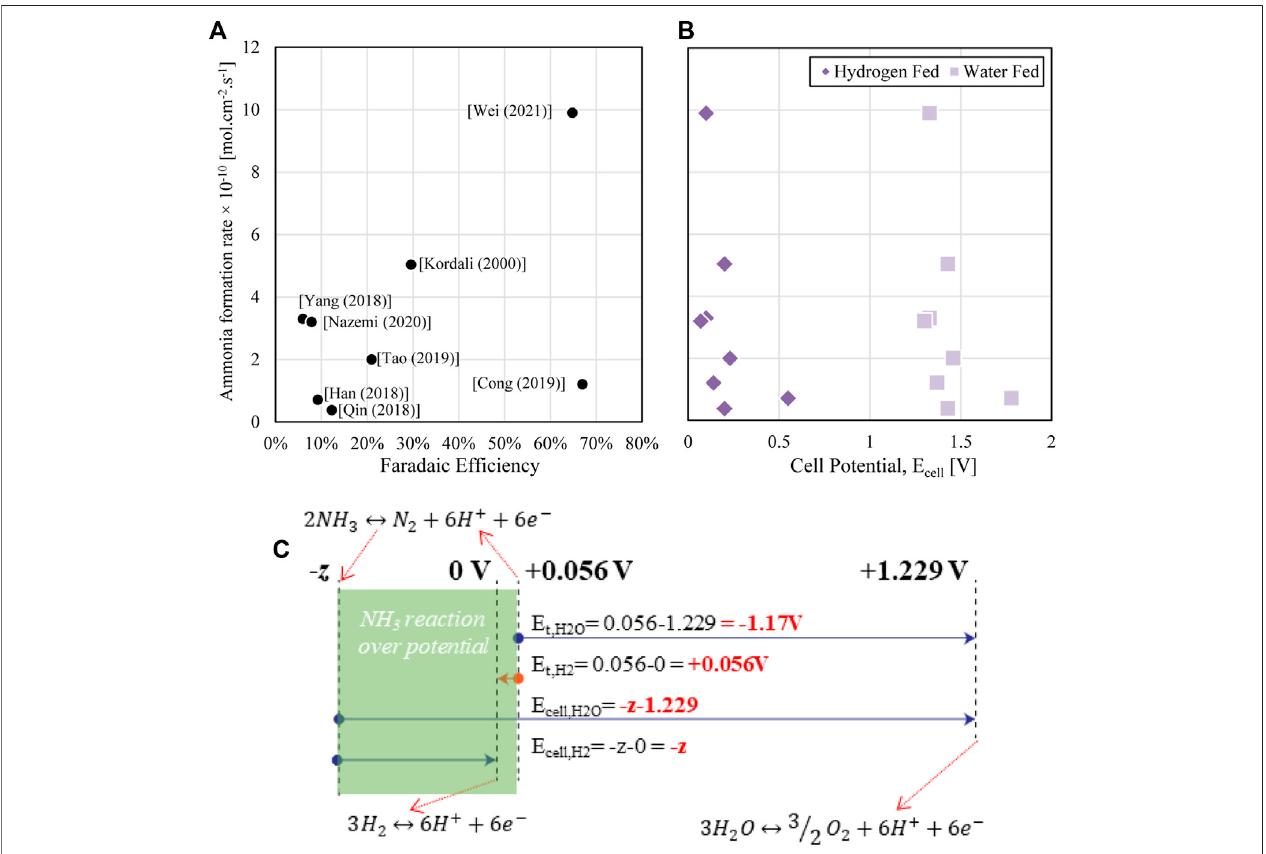
FIGURE2| (A) Reported performancefrom selected studies (Kordaliet al.,2000;Han et al.,2018; Qin et al.,2018; Yang et al., 2018;Cong et al., 2019;Tao et al., 2019; Nazemi et al., 2020; Wei et al., 2021) of faradaic ef fi ciency and ammonia formation rate, (B) theoretical full cell potential for reported literature half-cell and relationshiptoammoniaformationrate[ y -axissameas (A) ] (C) schematicrepresentationofcellpotentialcalculationinimpactofammoniaformationoverpotentialinVvs